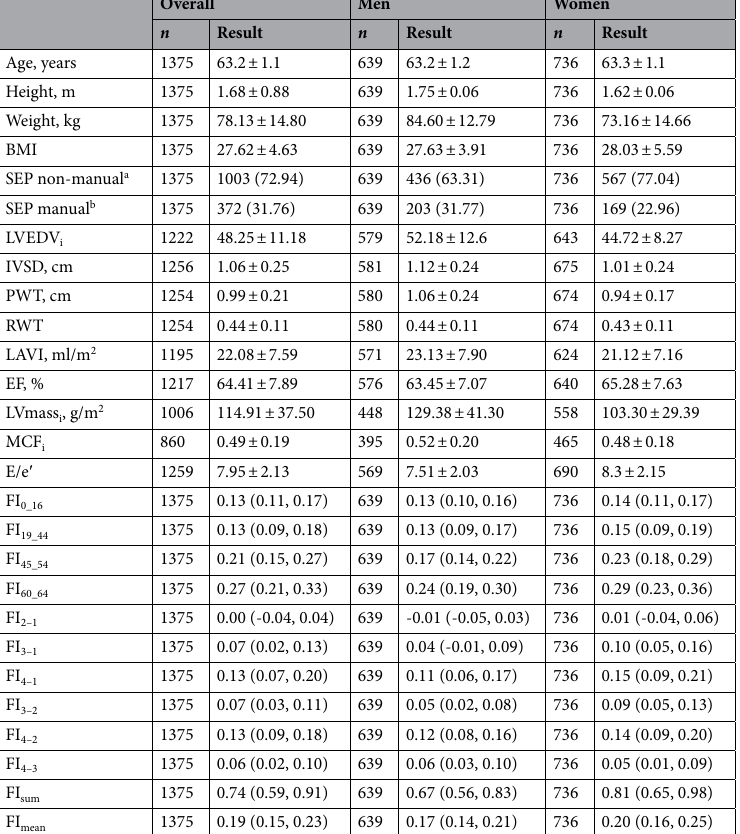
Table 1. Characteristics of the MRC NSHD sample considering participants with less than < 20% missing health deficit data and having at least one echocardiographic parameter of interest (EF, MCF i , LVmass i or E/e ′ ). Data presented as mean ± standard deviation, median (interquartile range) or counts (%) as appropriate. BMI body mass index, EF ejection fraction, FI 0_16 frailty index at 0–16 years, FI 19_44 frailty index at 19–44 years, FI 45_54 frailty index at 45–54 years, FI 60_64 frailty index at 60–64 years, FI 2–1 step change in deficit accumulation between FI 19_44 and FI 0_16 , FI 3–1 step change in deficit accumulation between FI 45_54 and FI 0_16 , FI 4–1 step change in deficit accumulation between FI 60_64 and FI 0_16 , FI 3–2 step change in deficit accumulation between FI 45_54 and FI 19_44 , FI 4–2 step change in deficit accumulation between FI 60_64 and FI 19_44 , FI 4–3 step change in deficit accumulation between FI 60_64 and FI 45_54 , FI sum sum of FI 0_16 , FI 19_44 , FI 45_54 and FI 60_64 , FI mean mean of FI 0_16 , FI 19_44 , FI 45_54 and FI 60_64 , IVSD interventricular septal thickness in diastole, LAVI left atrial volume indexed to body surface area, LVEDV I left ventricular end-diastolic volume indexed by the body surface area, LVmassi left ventricular mass indexed to body surface area, MCF i myocardial contraction fraction indexed to body surface area, PWT left ventricular posterior wall thickness in diastole, RWT relative wall thickness, SEP